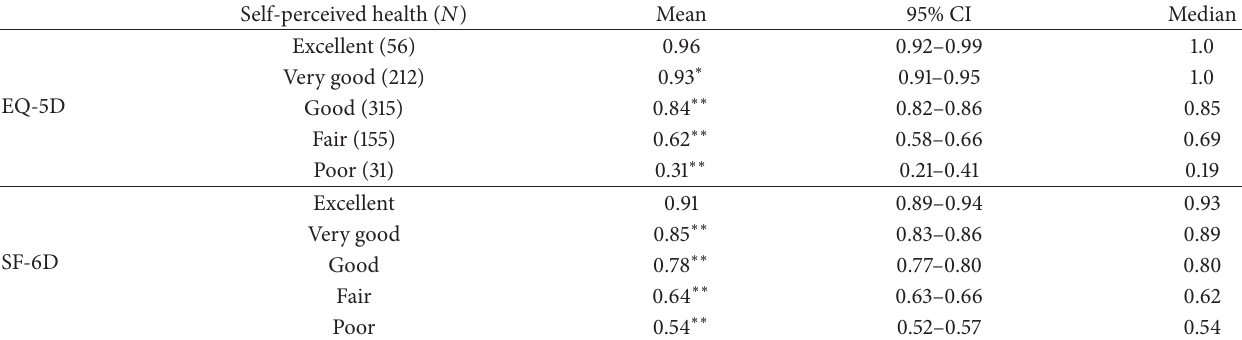
Table 6: EQ-5D and SF-6D index scores that depend on subjectively perceived health derived from question one in SF-36.